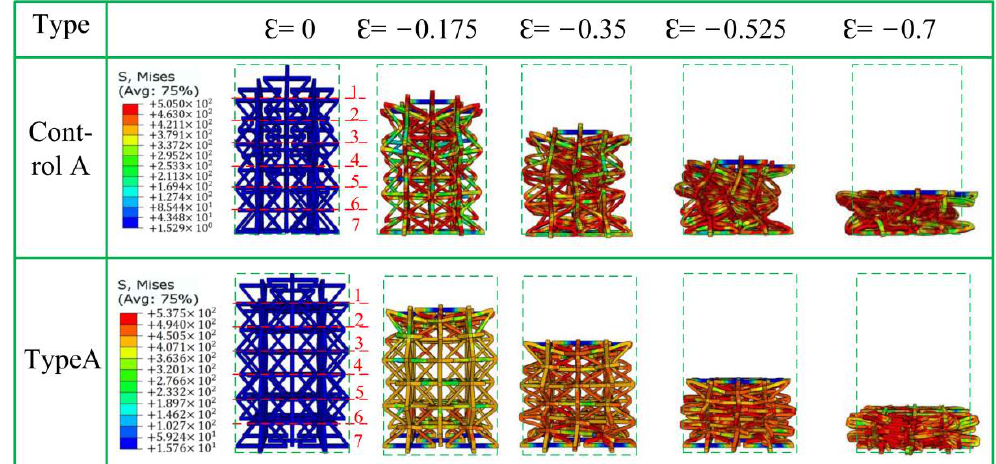
Figure 12. Fragmentation process of type A in the y direction.